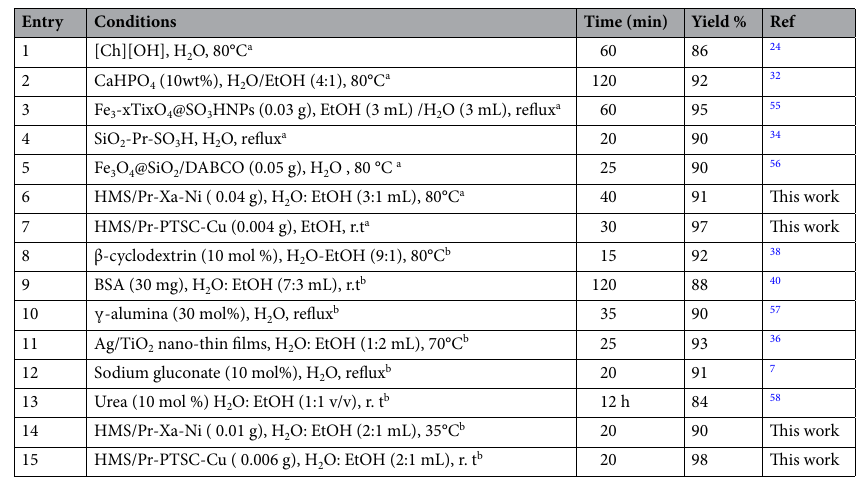
Table 11. Comparison results of HMS/Pr-Xa-Ni and HMS/Pr-PTSC-Cu with other catalysts. a Reaction of 4-chlorobenzaldehyde, dimedone and malononitrile for the synthesis of 2–amino–3–cyano–7,7– dimethyl–4-(4-chlorophenyl)–5–oxo-4H–5,6,7,8-tetrahydro benzopyran. b Reaction of 4-chlorobenzaldehyde, malononitrile, ethyl acetoacetate and hydrazine hydrate for the synthesis of 6-amino-4-(4-chlorophenyl)-3-